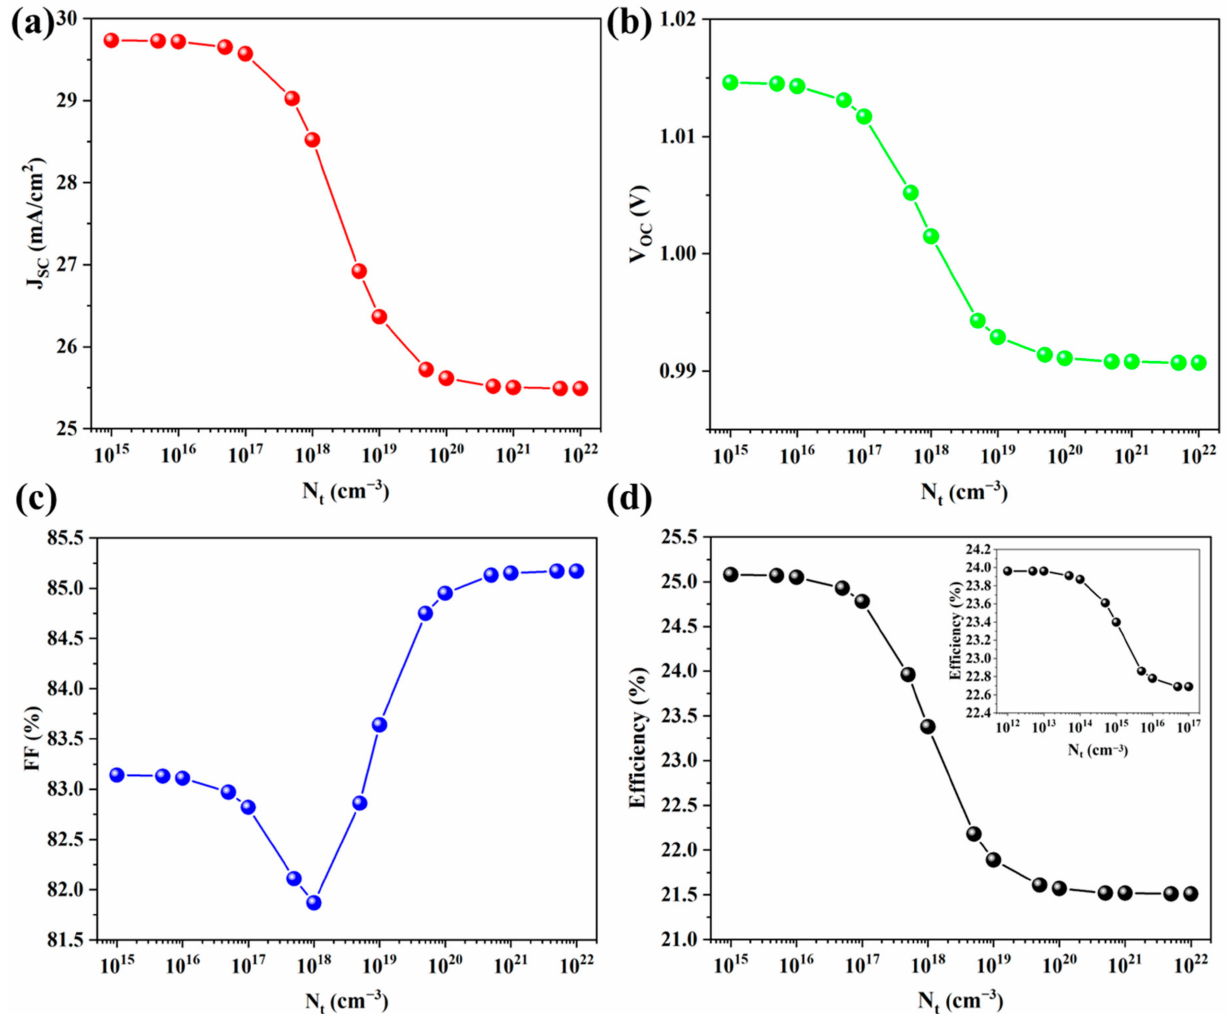
Figure 6. Effect of defect density of HTL on ( a ) J SC , ( b ) V OC , ( c ) FF, and ( d ) PCE of perovskite solar cell with CsSnI 3 (The inset shows the effect of interface defect density on